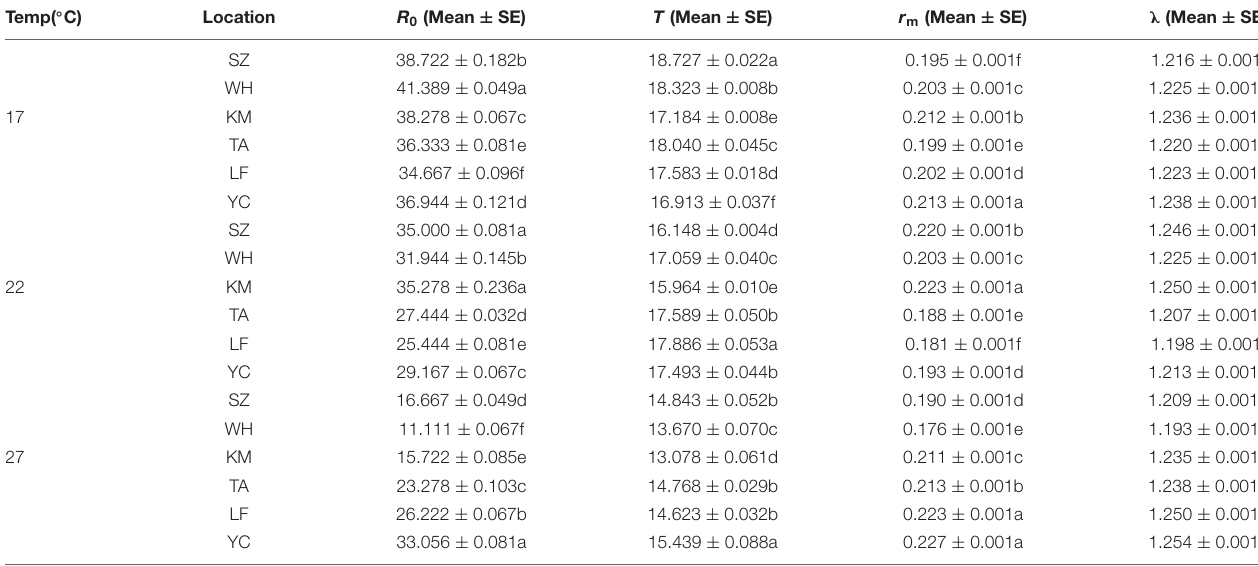
TABLE 2 | Life-table parameters at each location at different temperatures. Temp( ◦